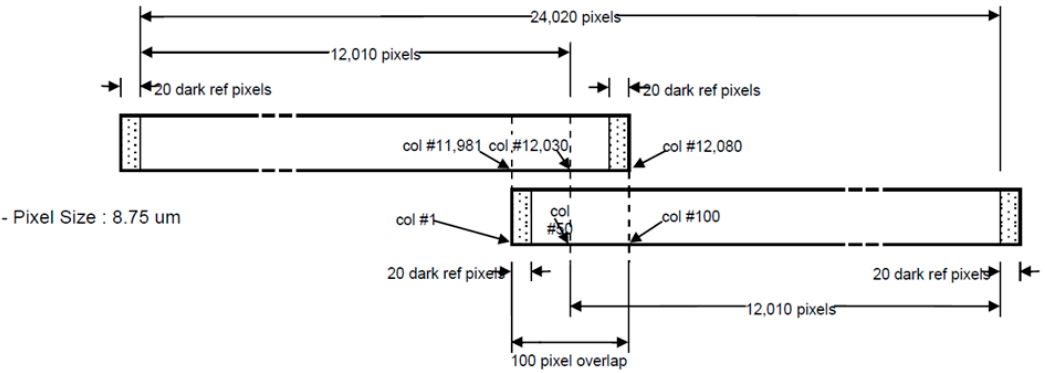
Figure 2. Kompsat-3A AEISS-A panchromatic CCD-lines configuration with an overlapping zone (the scan direction is upward).